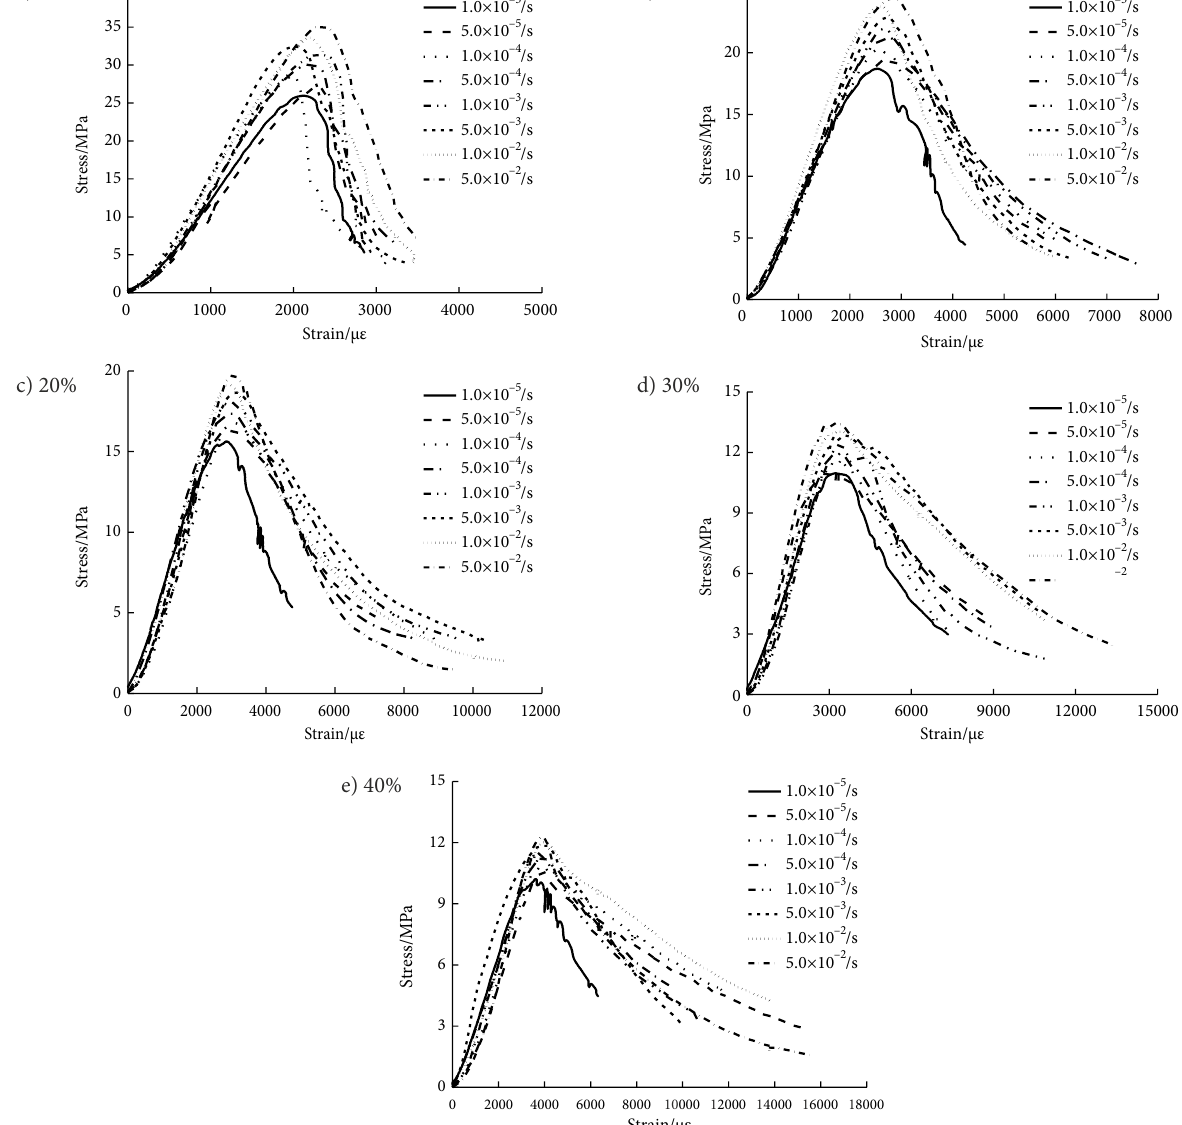
Figure 8. Compressive dynamic stress-strain curves of rubber concrete under different loading